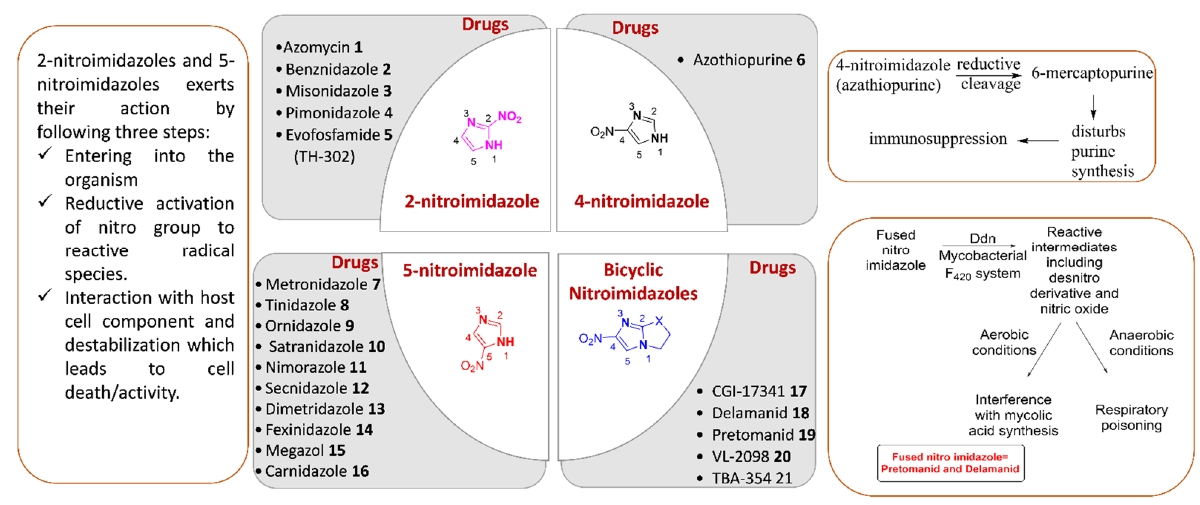
Figure 4. Mechanistic overview of nitroimidazole-based